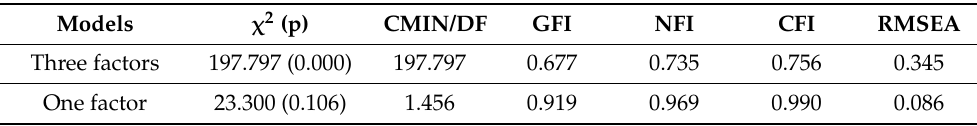
Table 1. Fit indexes of WAMI factorial